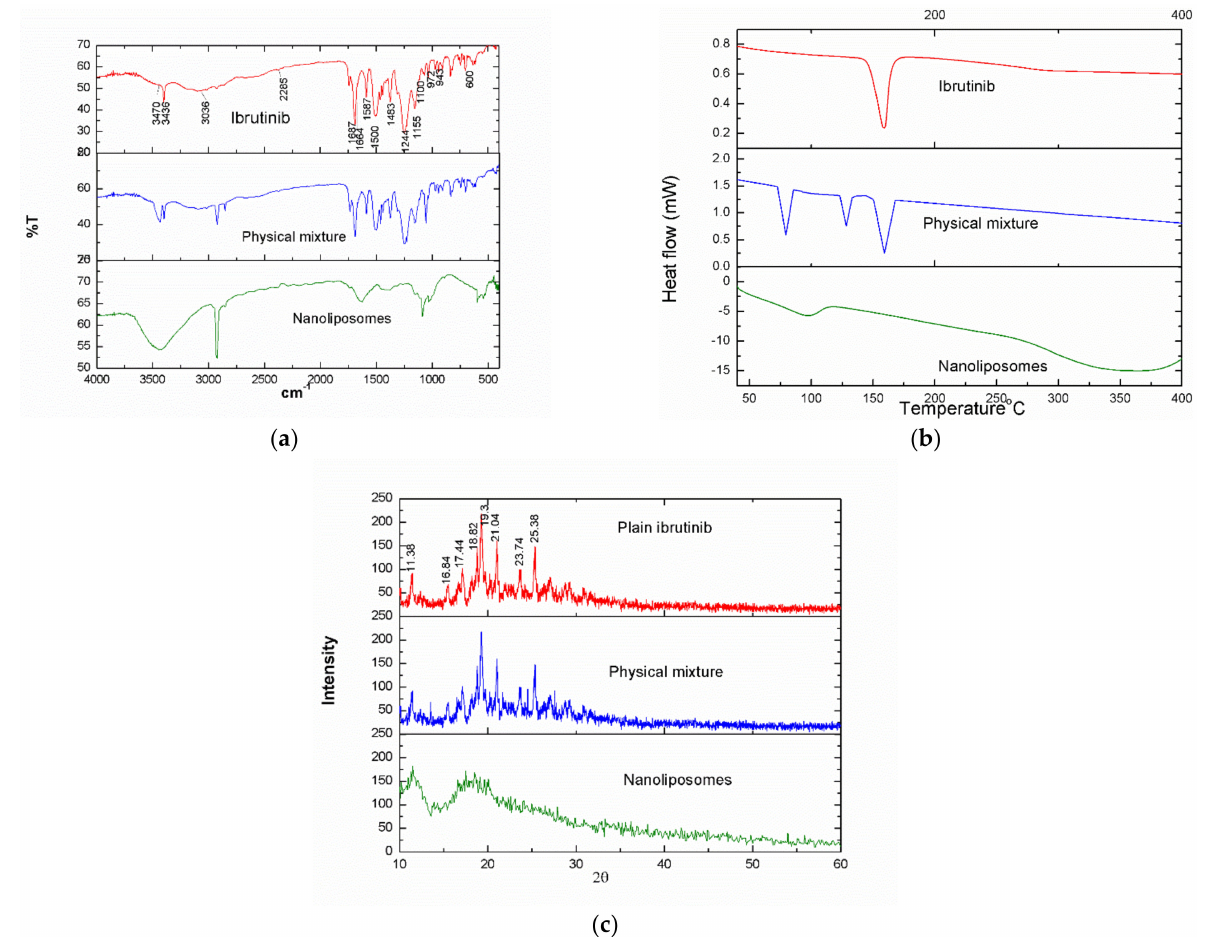
Figure 7. ( a ) FTIR spectra of the plain ibrutinib, the physical mixture, and the nanoformulation; ( b ) DSC thermogram of the plain ibrutinib, the physical mixture, and the nanoformulation; ( c ) XRPD pattern of the plain ibrutinib, the physical mixture, and the